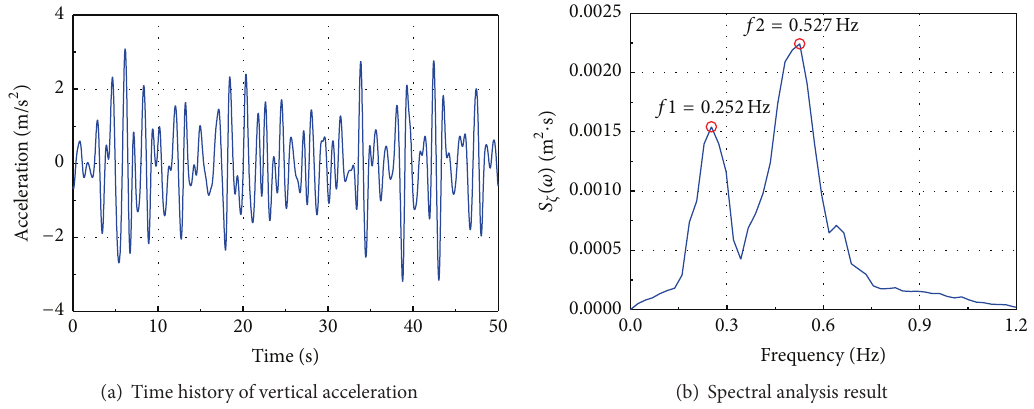
Figure 10: Sea waves measured and the spectral analysis result.